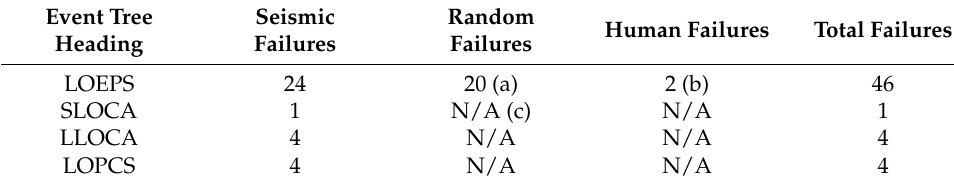
Figure 7. Event tree used for seismic SUPSA. Table 2. Basic events in fault trees for different accident sequence headings. Event